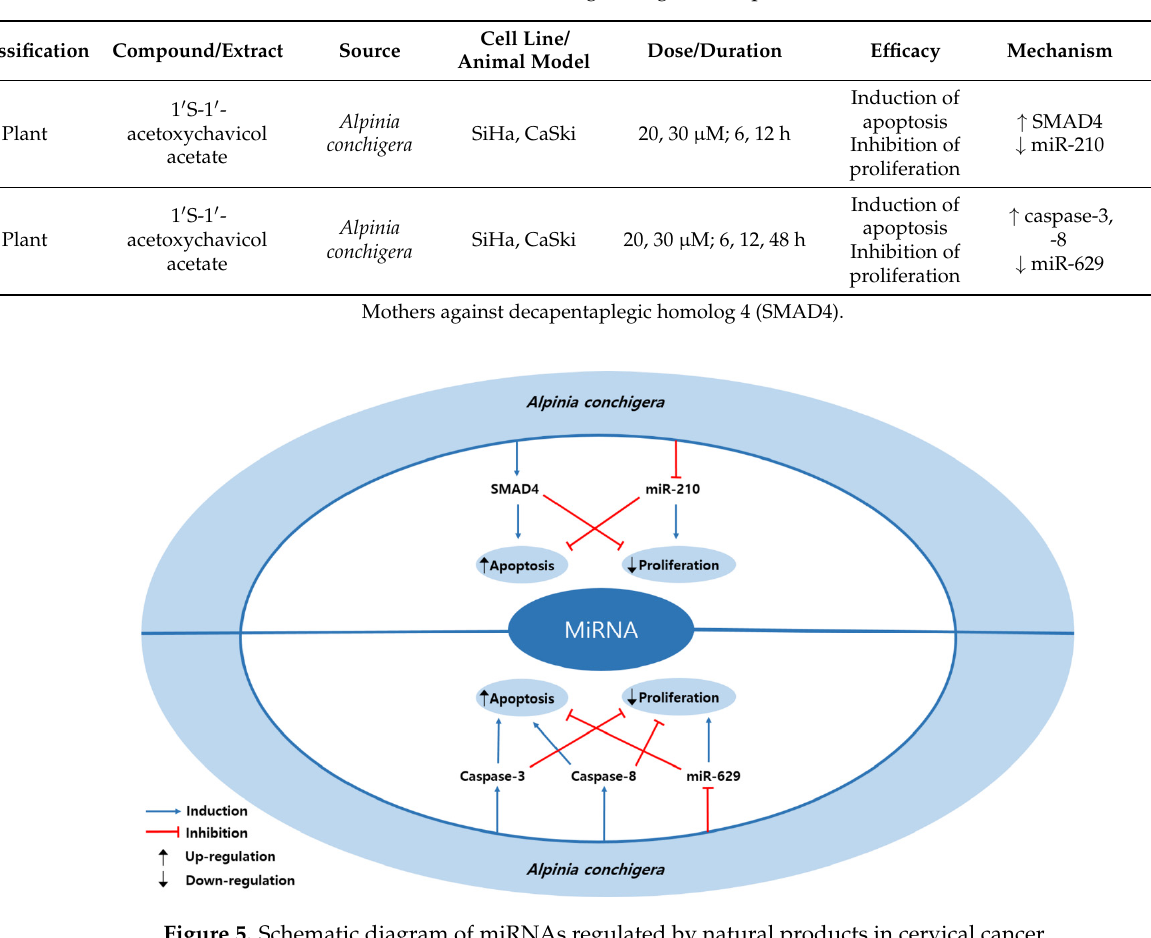
Table 6. MicroRNA regulating natural products.